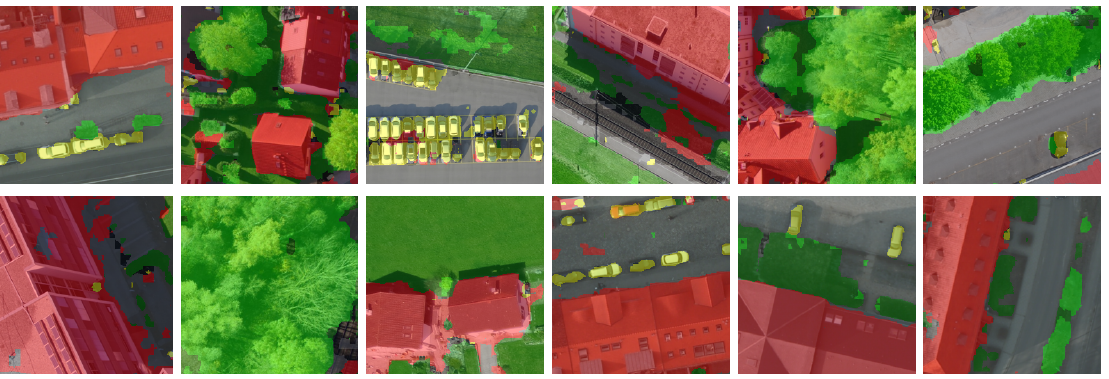
Figure 3. Example of semantic segmentation results on our validation images with a fine-tuned fully convolutional network (FCN) model [49] trained on UAV and aerial images. Visualization is color coded for buildings ( ), streets ( ), low vegetation ( ), high vegetation ( ), cars ( ), and others (